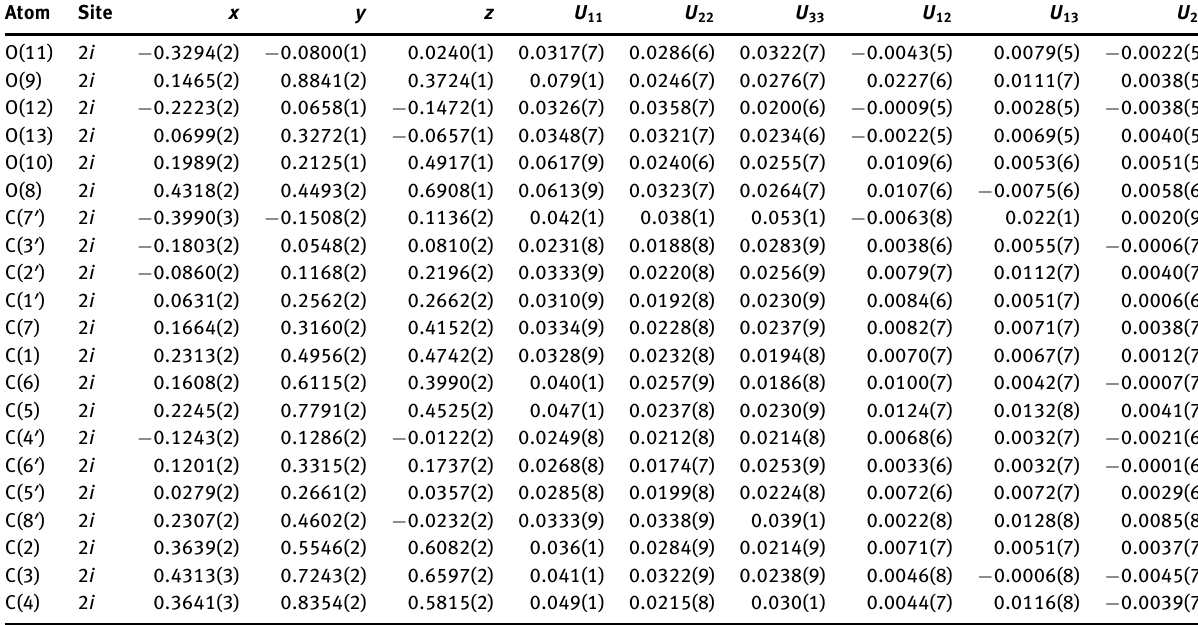
Table 3: Atomic displacement parameters (Å 2